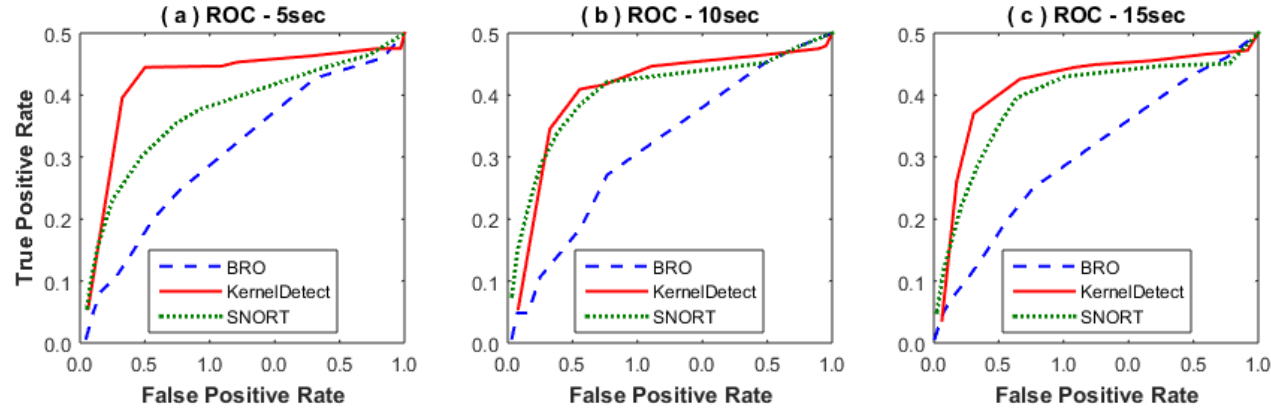
Figure 10. Threat mitigation for each IDS under 100K, 200K, and 500K SYN flagged packet flood attack using 10 second threshold detection technique and represented as a box plot.